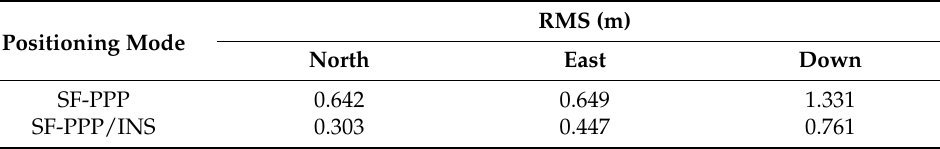
Table 2. RMS of position differences in the three directions of SF-PPP and SF-PPP/INS tight